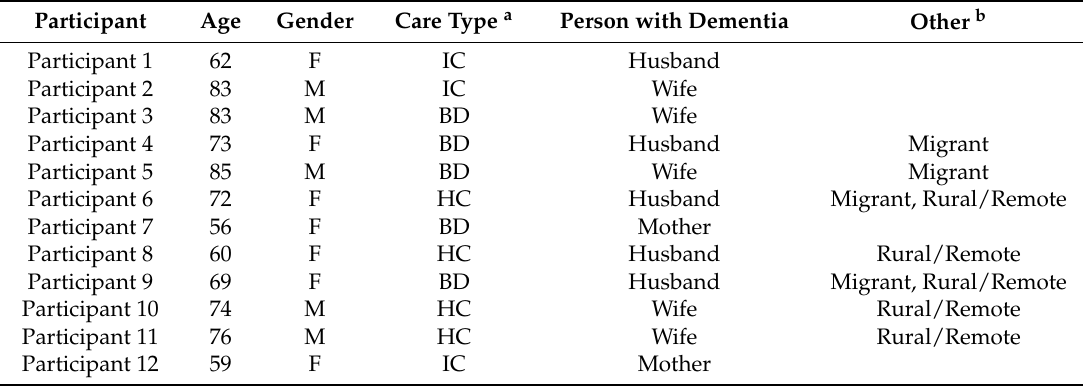
Table 1. Participant